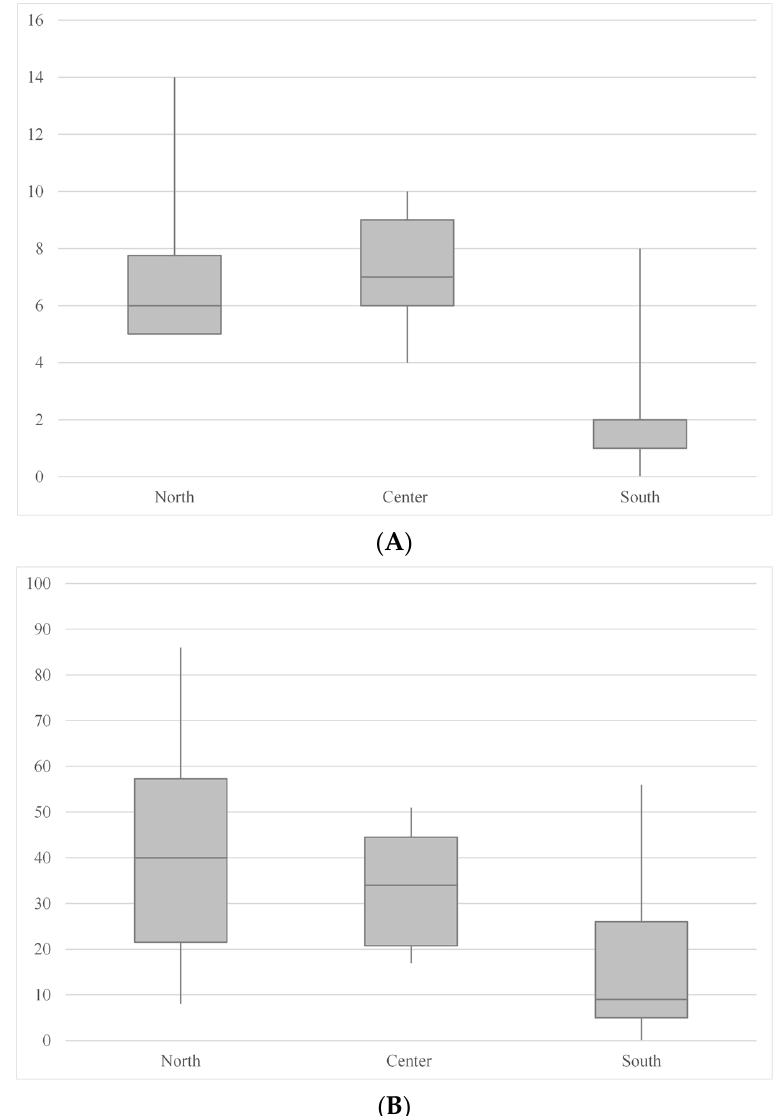
Figure 5. Box plot of ( A ) species richness and ( B ) abundance of troglobite, troglophile, and acci- dental spiders in 35 caves at the north, center, and south of Israel (minimum, first quartile, me- dian, third quartile, and maximum). Table 1. Spider species richness and abundance (troglobite, troglophile, and accidentals) in caves by region (35 caves). Numbers denoted a specific cave (see Appendix A).